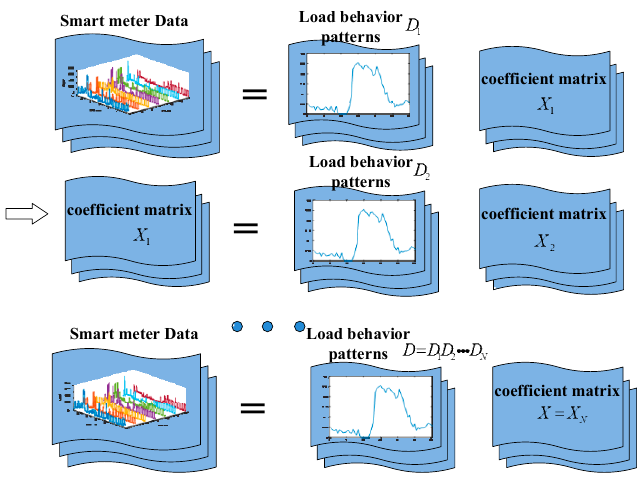
Figure 2. Schematic diagram of deep equipment behavior patterns extraction.